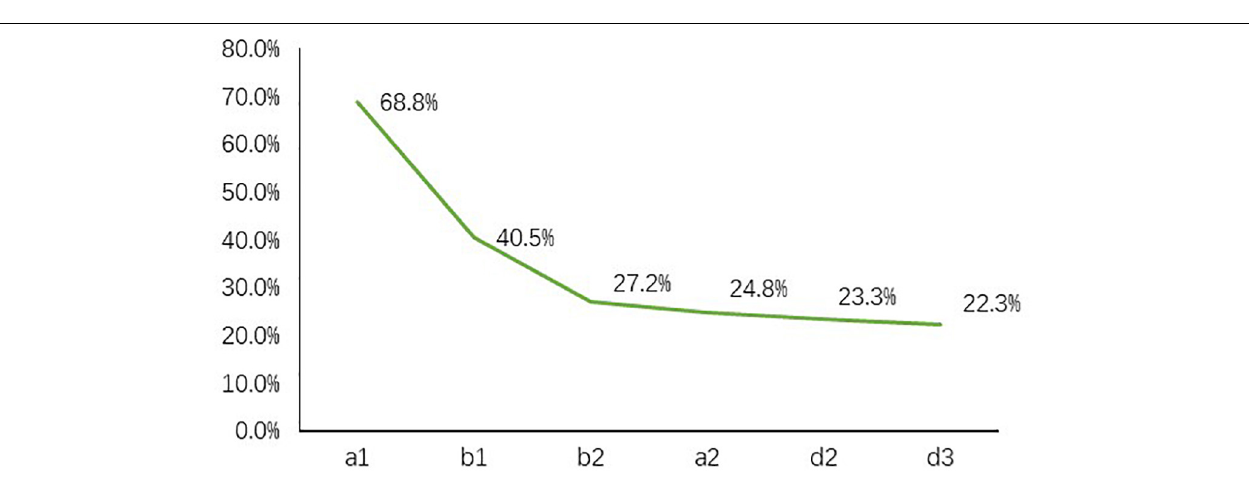
FIGURE 4 | The shape of the OGU best user searching curve indicates that it becomes smoother after the third